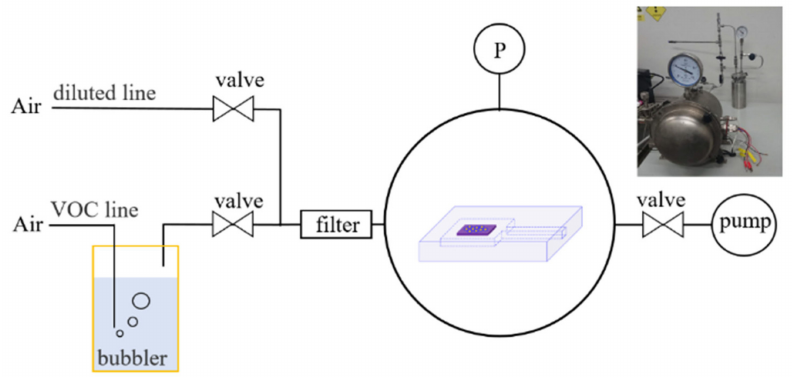
Figure 3. Schematic diagram of ethanol production and gas delivery system. On the top right is a picture of the real system.